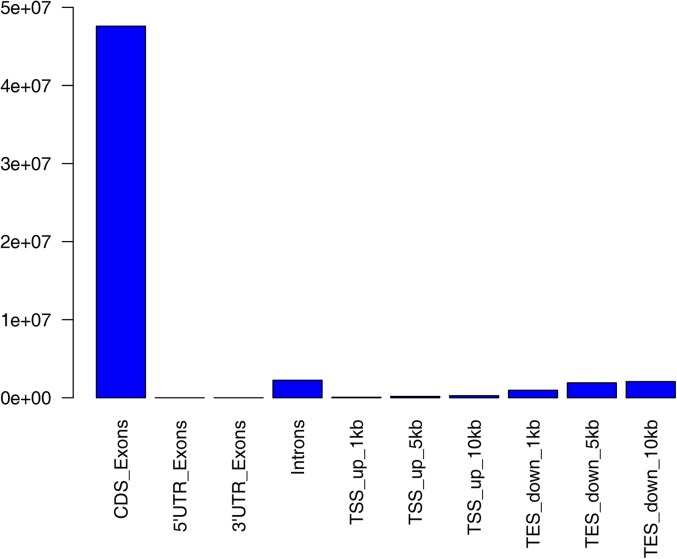
Detailed distribution of reads mapped to the reference genome. CDS, coding sequence; TES_down, downstream of the transcription ending site; TSS_up, upstream of the transcription starting site; UTR, untranslated regions.